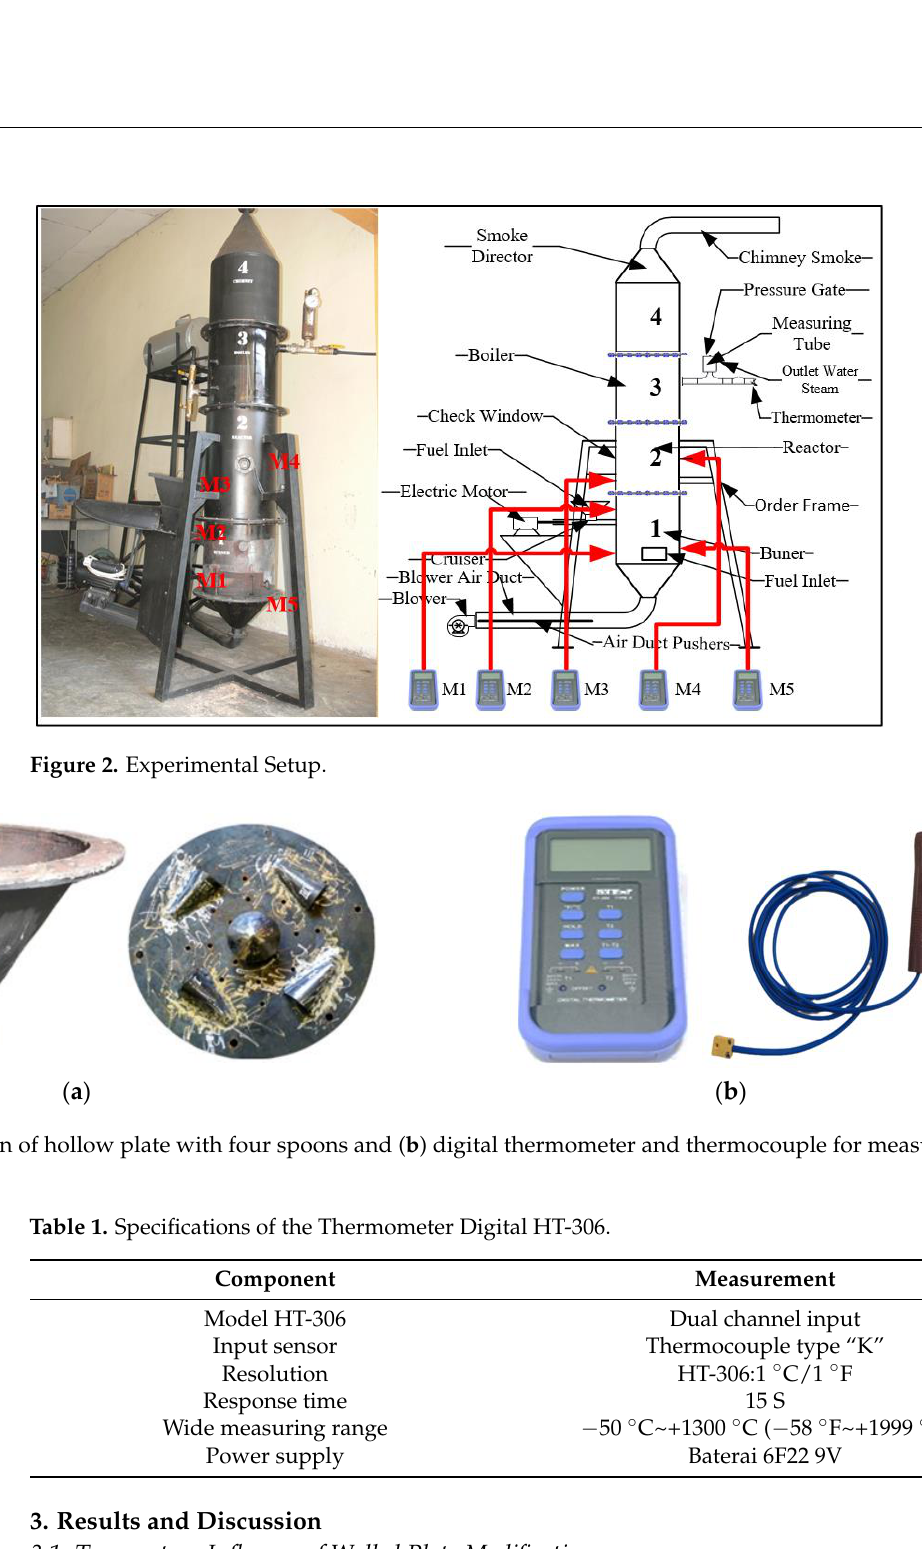
Table 1. Specifications of the Thermometer Digital HT-306.